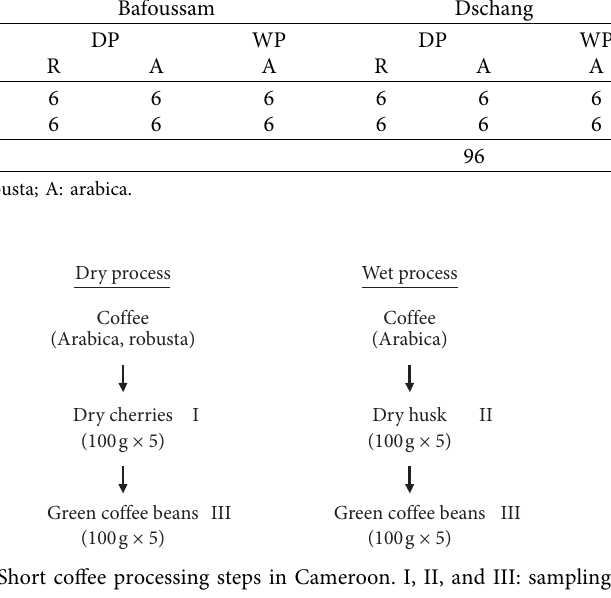
Table 1: Summary of the sampling procedure in the three Cameroonian regions and the number of samples collected. Sampling period